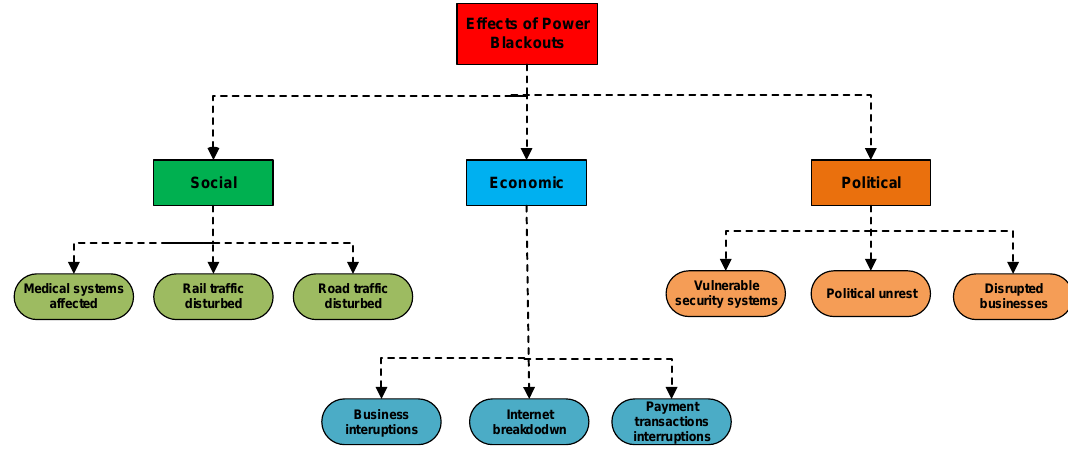
Figure 5. Major electric power system blackout